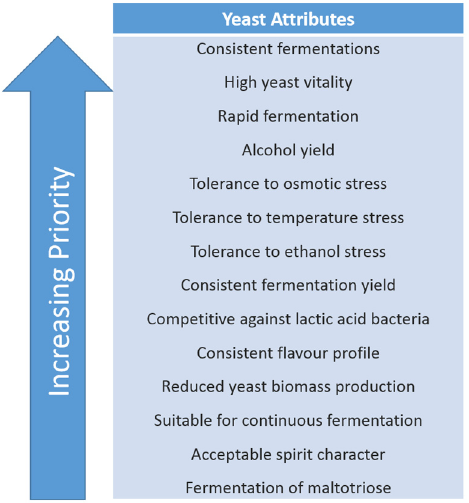
Figure 2. Summary of the desired attributes of distilling yeast for neutral spirit fermentations. The more desirable attributes are located at the top, and this decreases down the table (after Walker, et al. [33]).